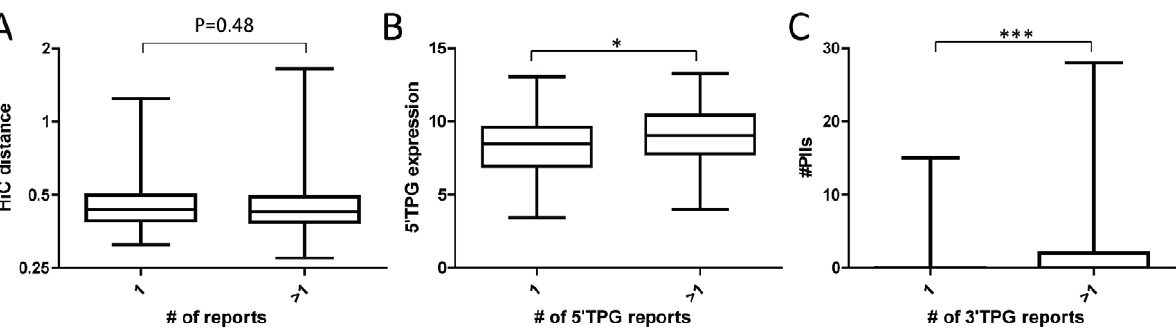
Figure 10. Clinical frequency of chromosomal translocations is influenced by some features of TPGs but is not dependent on their spatial proximity. A . Hi-C distance (calculated as contact frequency) between TPG-containing loci for rare (reported once) and frequent (reported more than once) translocations. B : expression levels of rare and frequent 5 9 TPGs. C : number of protein interaction interfaces in rare and frequent 3 9 TPGs. *, ***: P , 0.05, 0.0001; All P-values calculated using Mann-Whitney U